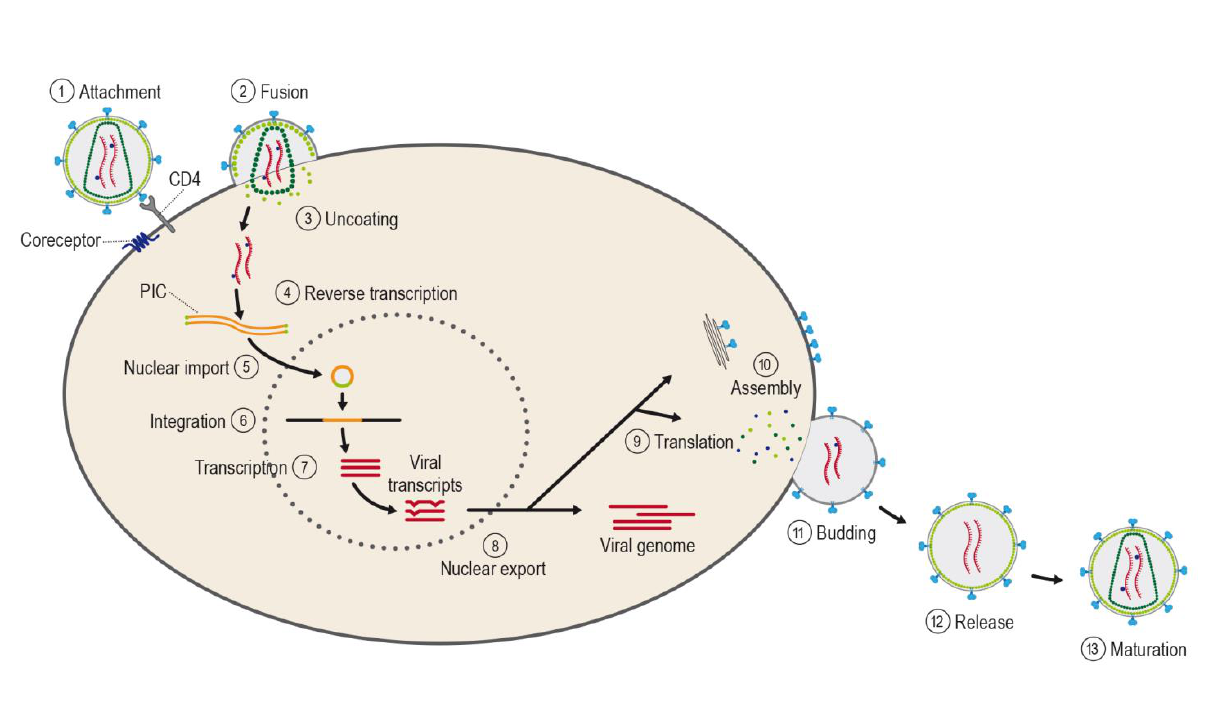
Figure 4: Different steps of the viral life cycle. The infection cycle begins with the attachment of the envelope (Env) glycoprotein spikes with the CD4 receptor and the membrane-spanning coreceptor (step 1), leading to fusion of the viral and cellular membranes and entry of the viral particle into the cell (step 2). Partial uncoating (step 3) facilitates reverse transcription (step 4), which in turn yields the pre-integration complex (PIC). Following import into the cell nucleus (step 5), PIC-associated integrase orchestrates the formation of the integrated provirus (step 6). Proviral transcription (step 7) yields viral messenger RNAs (mRNAs) of different sizes. Following export (step 8), mRNAs serve as templates for protein production (step 9), and genome-length RNA is incorporated into viral particles with protein components (step 10). Viral-particle budding (step 11) and release (step 12) is accompanied or soon followed by protease-mediated maturation (step 13) to create an infectious viral